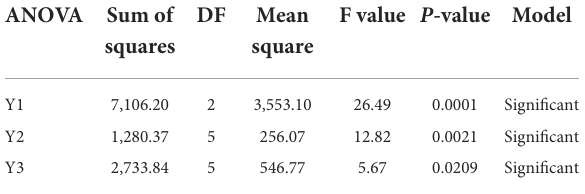
TABLE 2 ANOVA for response surface quadratic model for checking model suitability for Y1, Y2, and Y3. ANOVA Sum